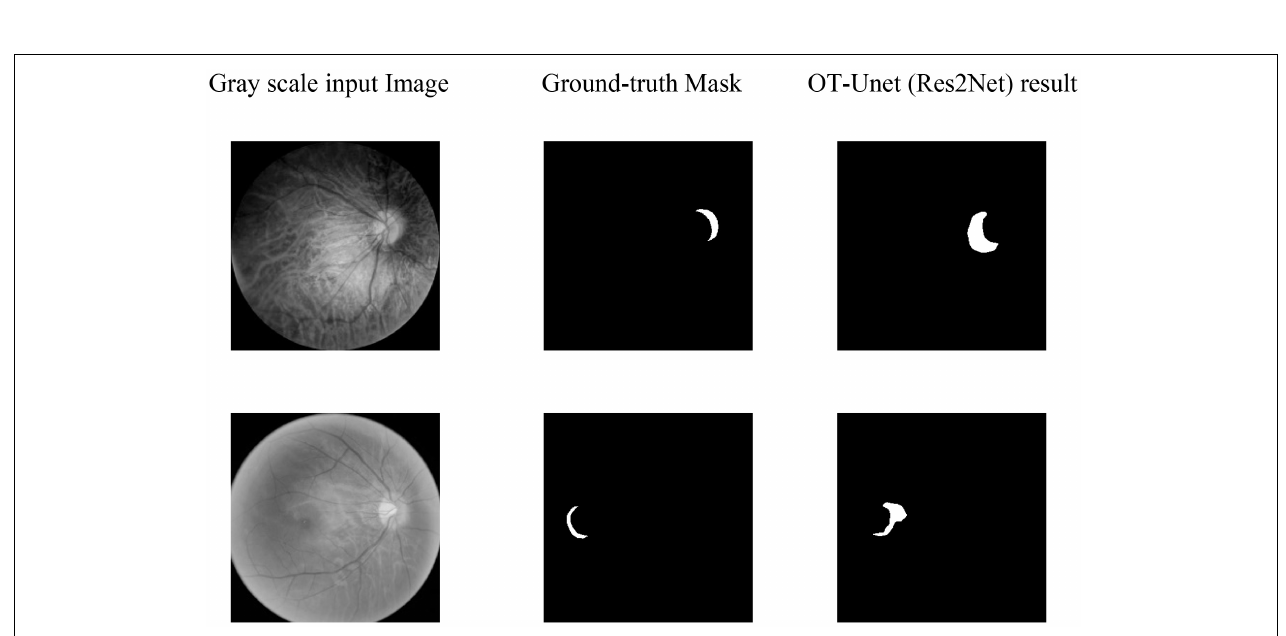
FIGURE 9 | Segmentation of extremely small lesions: It can be seen that the segmentation prediction map does not correspond to the Ground-truth Mask at all.